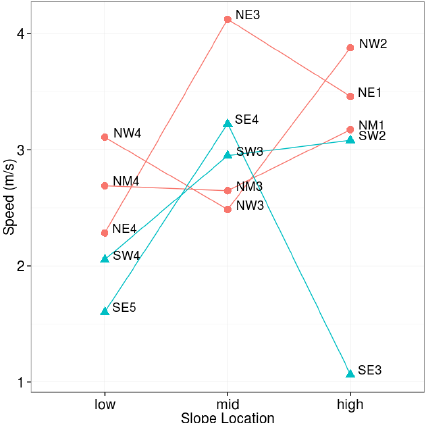
Figure 14. Average wind speeds for sensors at three slope locations (low, mid, and high) along five transects during the afternoon flow regime (17:00 LT) at the Salmon River Canyon site. Blue and red lines are transects on the southern and northern sides of the river,